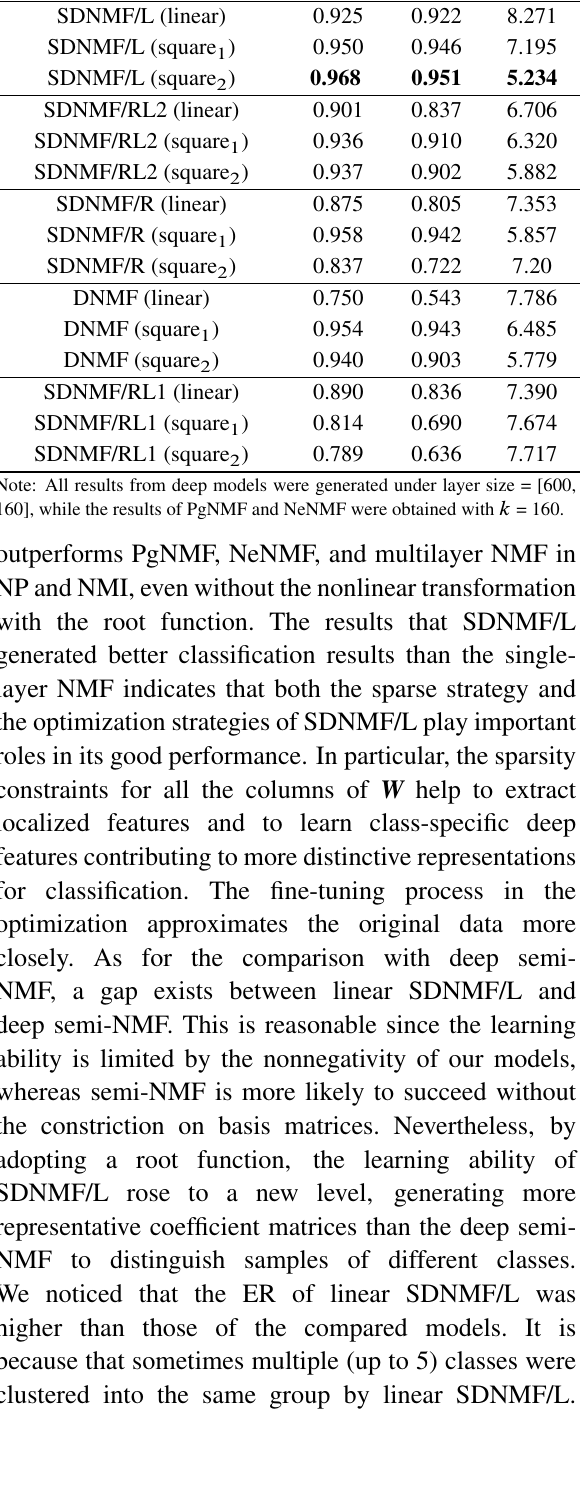
Table 2 Comparison of NMF-related models on PIE data.